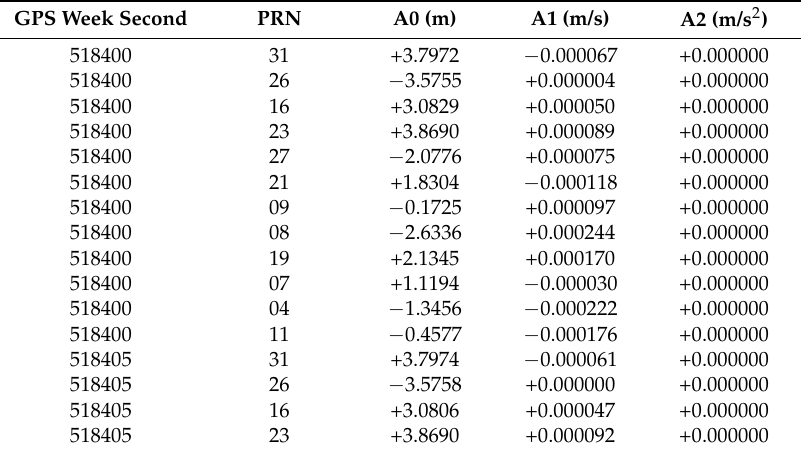
Table A2. Sample satellite orbit corrections provided by SSR messages.